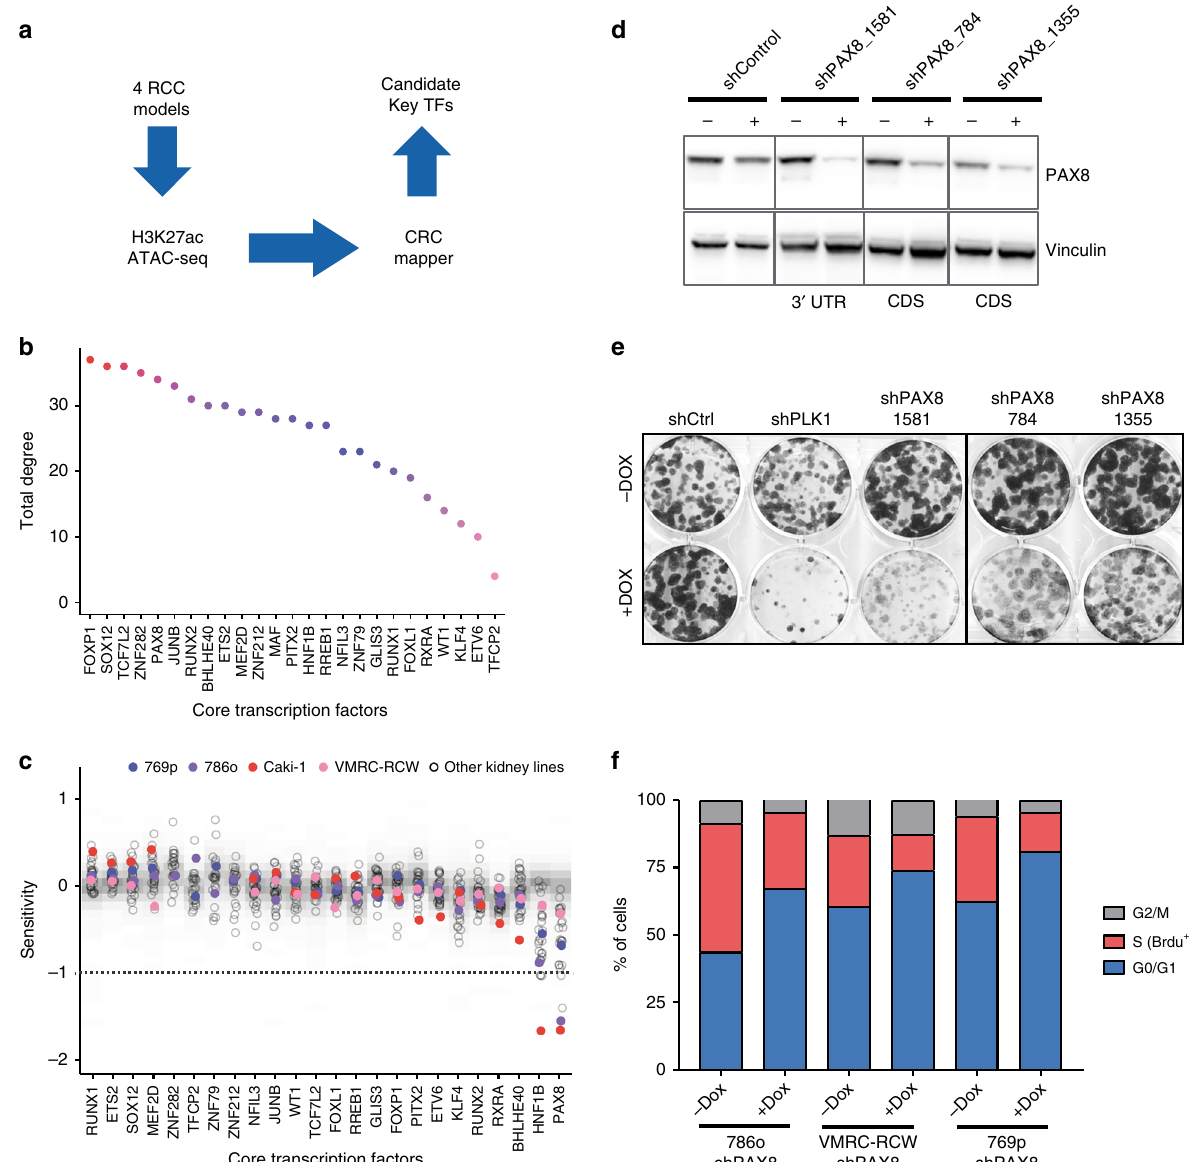
Fig. 1 Core regulatory circuitry analysis identi fi ed PAX8 as a candidate oncogene in RCC. a Diagram of the experimental/computational pipeline to identify critical TFs in RCC. b CRC mapper output as TFs ( x -axis) ranked by total degree ( y -axis) in RCC. Total degree is a measure of a TFs ’ contribution based on how often a given TF can participate in a regulatory interaction with the other TFs. c Sensitivity pro fi le for CRC TFs ( x -axis) in combined shRNA datasets (DRIVE, Achilles, Marcotte), where smaller values indicate that the cell line is more dependent on a given gene. Empty dots represent the sensitivity score for each TF in a RCC cell line. Colored dots represent the cell lines originally used in the CRC mapping. Shaded gray represents the distribution of sensitivity values for each TF in cell lines from other lineages. Horizontal dashed line at − 1 represents the threshold for signi fi cant dependency. d Western blot validation of PAX8 knockdown ef fi cacy in 786o cells infected with dox-inducible shRNAs. e Colony formation assay of 786o cells bearing various doxycycline-inducible shRNAs performed during 10 days. PLK1 is an essential gene in 786o cells and it is a positive control in this assay. f Cell cycle analysis by fl ow cytometry using PI-BrdU labeling in RCC cell lines bearing shPAX8_1581 upon 4 days of treatment with PAX8 across the same panel of kidney cancer cells. First, we Fig. 2B), consistent with the notion of PAX8 controlling kidney identi fi ed a suitable antibody that could ef fi ciently immunopre- cell fate and pathogenesis. A large fraction of deregulated genes cipitate PAX8 upon crosslinking (Supplementary Fig. 2D). Since are involved in cell cycle (i.e., RPA in Fig. 2a), consistent with validated PAX8 target genes are exclusively expressed in thyroid decreased viability of RCC cells upon PAX8 knockdown and as cells (e.g., TG, TPO, and SLC5A5) 25 , we used the PAX8 promoter previously reported 23,24 . Interestingly, we noticed a signi fi cant enrichment of genes involved in diverse metabolic processes, such itself as a positive control for our ChIP assays, as previously as protein modi fi cations and iron oxidation (e.g., UBE2V2 and reported 26 (Supplementary Fig 2D, E). Our experiments identi- fi ed 3634 PAX8 peaks shared by three out of four cell lines and CP), according to Gene Ontology categories (Fig. 2a). used this dataset for further analysis. De novo TF motif fi nding in In order to identify the subset of genes directly controlled by the sequences underlying PAX8 peaks readily identi fi ed a motif PAX8, we sought to characterize the genome wide occupancy of